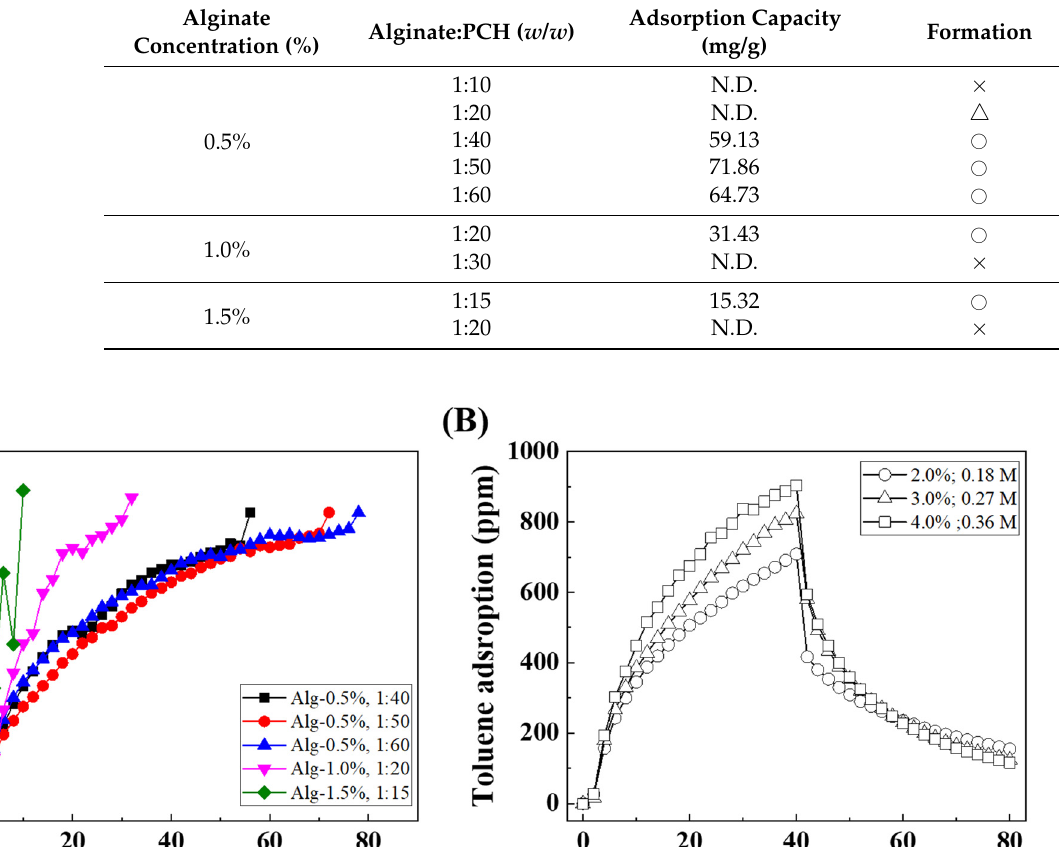
Table 2. Detailed information of optimization of Alg-PCH with toluene adsorption capacity.